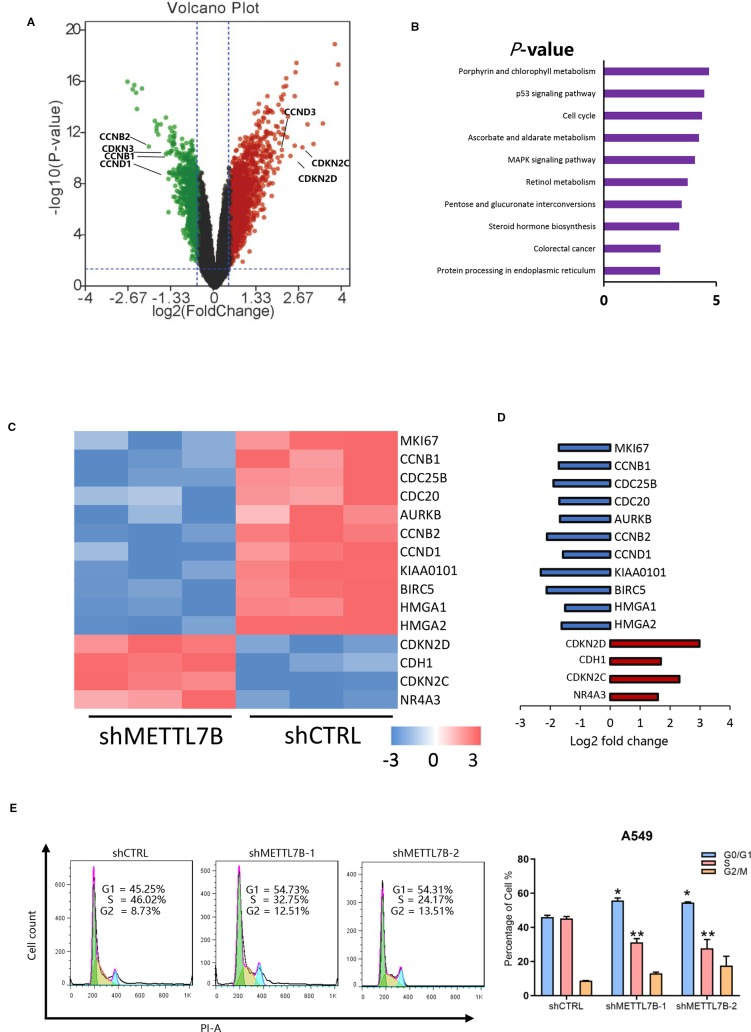
METTL7B regulates cell proliferation through modification of mRNA expression of cell cycle genes in non-small cell lung cancer (NSCLC). Affymetrix microarrays were used to analyze transcript profiles between shMETTL7B-A549 and shCTRL-A549 cells. (A) Volcano Plot demonstrated the distribution of the differentially expressed genes between shMETTL7B group and shCTRL group. The X-axis represents the logarithm conversion of the fold difference to base 2 and the Y-axis represents the logarithm conversion of the corrected significant levels to base 10. Values with a FC> 1.5, and p-value < 0.05 are indicated in red and are considered significantly up-regulated; while values with a FC<-1.5 and p-value < 0.0.5 are indicated in green and are considered down-regulated. The black dots represent genes with no significant differences. (B) Kyoto Encyclopedia of Genes and Genomes (KEGG) pathway analysis of differentially expressed mRNAs in A549 cells treated shMETTL7B. Cell cycle related genes are one of top three most significantly enriched signaling pathways with a p-value of 4.3E−5. (C) Heat map representation of microarray analysis of the cell cycle-specific differentially expressed transcripts within the shCTRL-A549 and shMETTL7B-A549 cells. (D) Fold change of cell cycle specific genes in (C). Up-regulated genes were in red and down-regulated genes were in blue in shMETTL7B-A549 cells. (E) Cell cycle analysis. (*p < 0.05, **p < 0.01). Error bars = mean ± SD, n = 3.